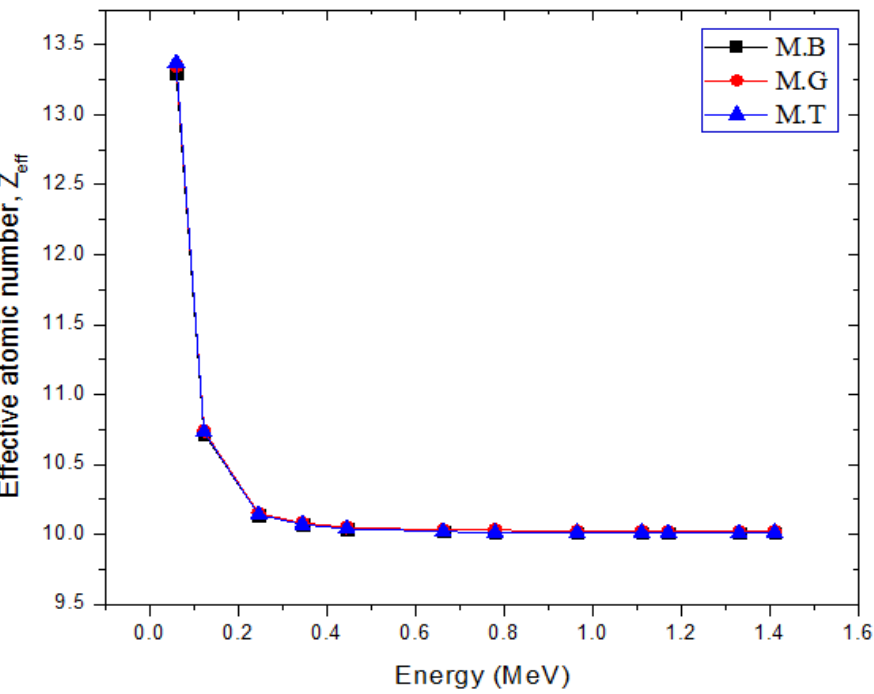
Figure 4. Variations of effective atomic number with respect to photon energy of the marble sam- ples.